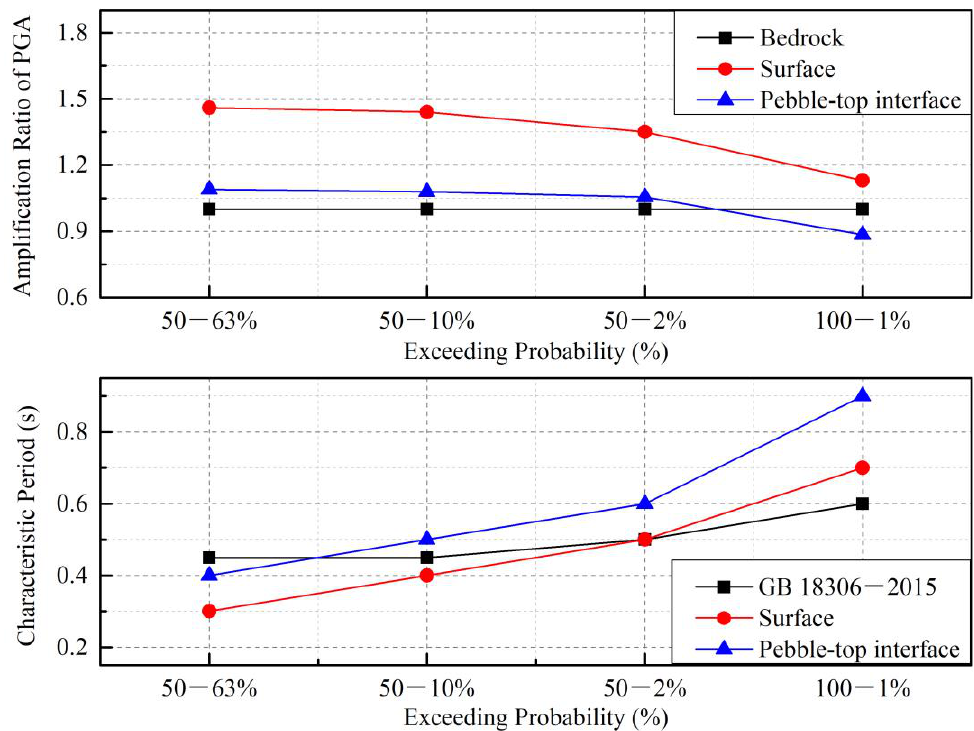
Figure 10. Amplification ratios of ground motion between pebble-top interface and ground surface under four seismic inputs.